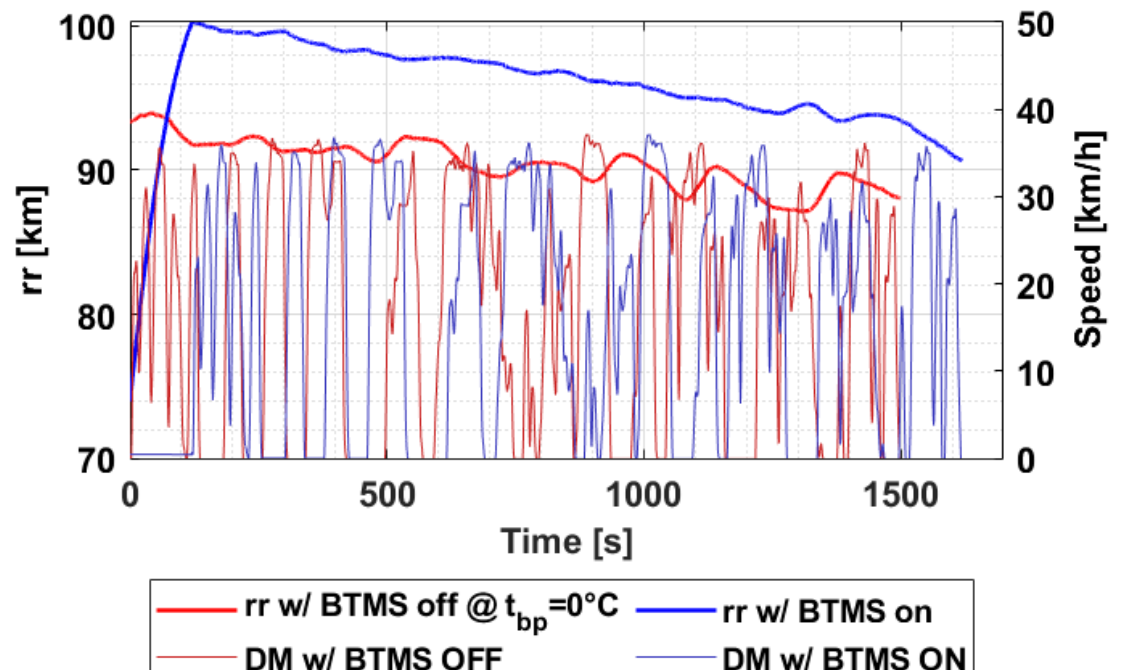
Figure 34. Comparison of residual driving range estimated with (blue curve) and without (red curve) thermal management of the BTMS for DM09 for an initial battery pack temperature of 0 °C.